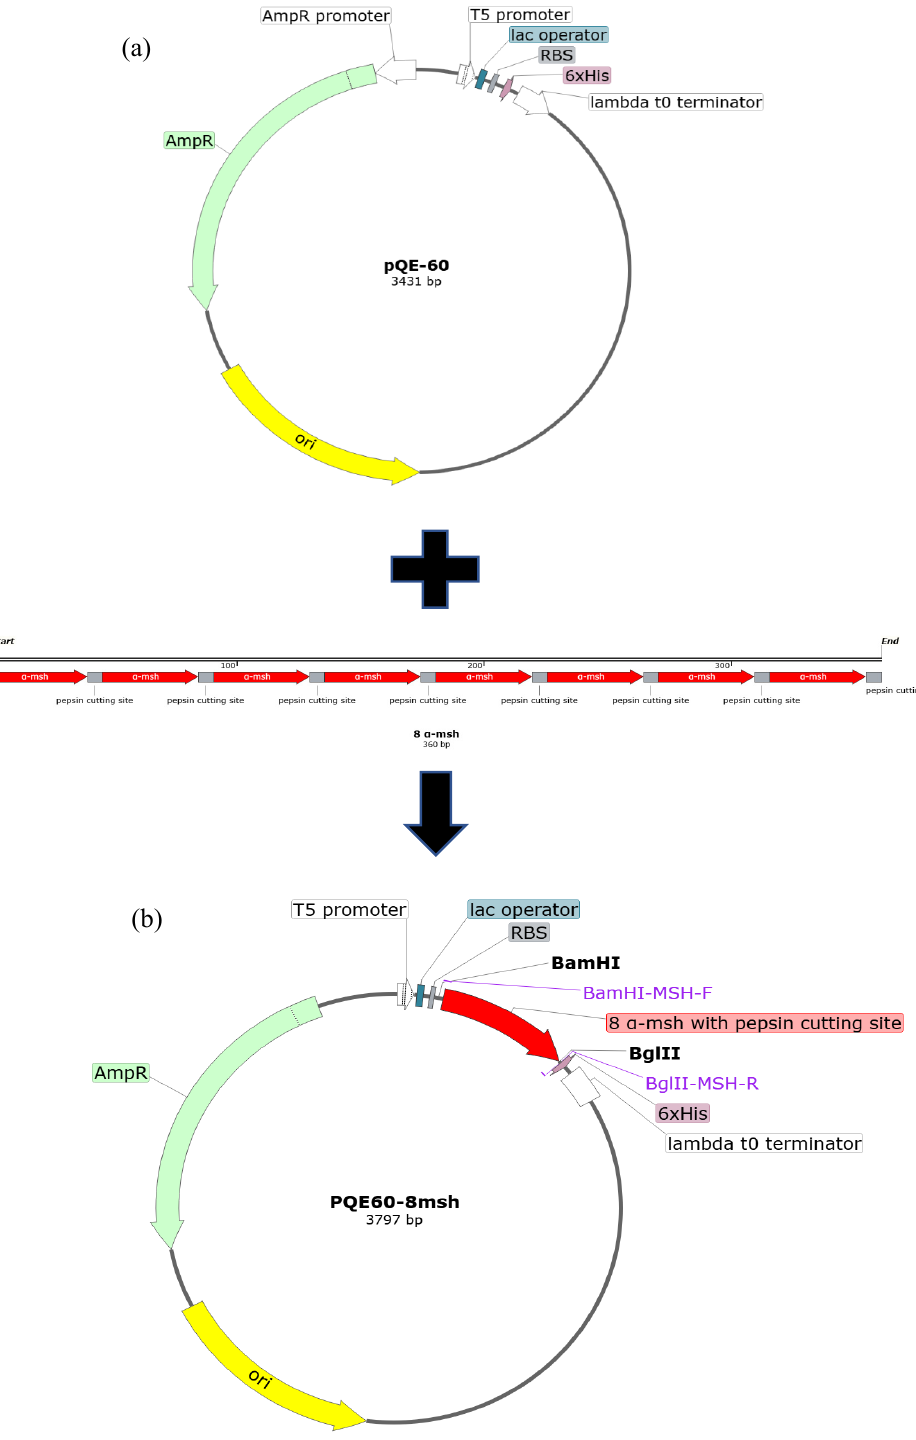
Figure 1. The plasmid map of pQE60-8 msh . ( a ) Schematic diagram of the gene sequence 8 msh encoding 8 α -MSH tandem repeat and the expression vector pQE60. Pepsin cutting sites (Gly-Phe, grey boxes) are introduced between the genes of msh (red arrows). The total length of the synthetic gene 8 msh is 260 bp. ( b ) 8 msh gene flanked with Bam HI and Bgl II re- striction sites on 5 ′ - and 3 ′ -ends, respectively, is subcloned into the multiple cloning sites of pQE60 with the fusion of 6xHis-tag at the C-terminus of 8 α -MSH tandem repeat.